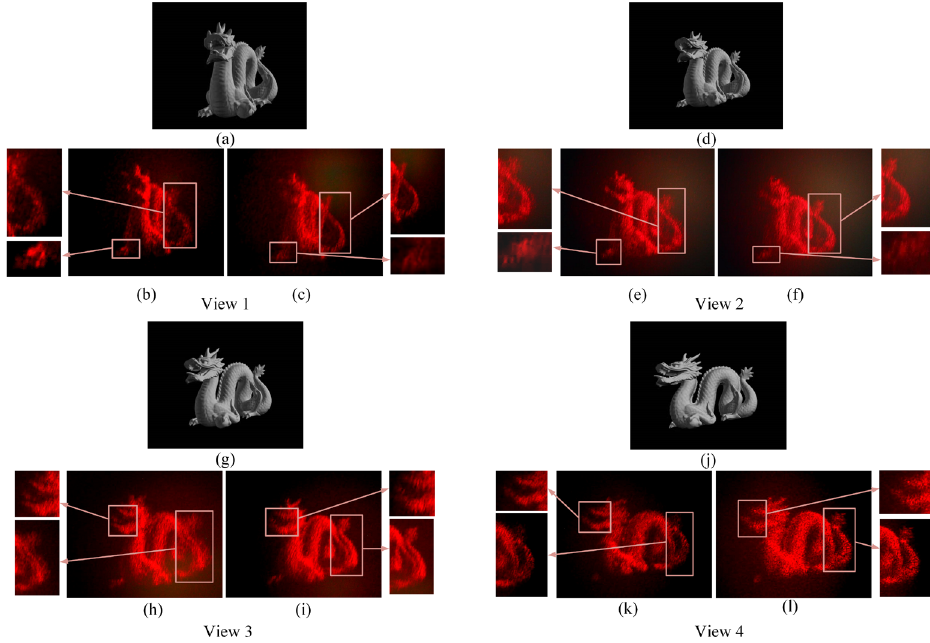
Figure 9. ( a ) The image of view 1. The captured reconstructed image of view 1 ( b ) the camera focused on the claw ( c ) the camera focused on the tail ( d ) The image of view 2. The captured reconstructed image of view 2 ( e ) the camera focused on the claw ( f ) the camera focused on the tail ( g ) The image of view 3. The captured reconstructed image of view 3 ( h ) the camera focused on the mouth ( i ) the camera focused on the tail ( j ) The image of view 4. The captured reconstructed image of view 4 ( k ) the camera focused on the mouth (l) the camera focused on the tail.